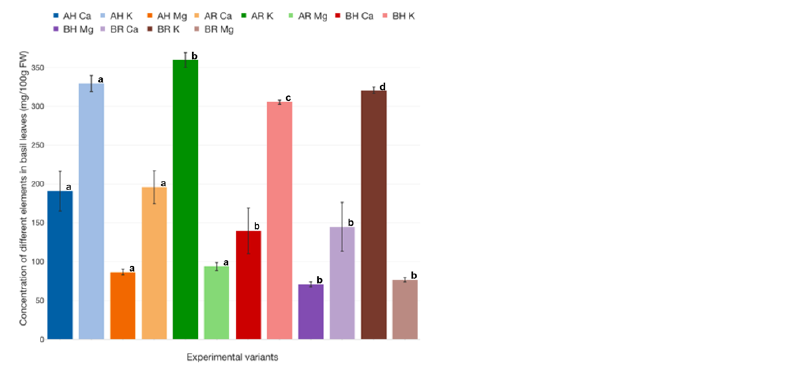
Figure 32. The concentration of different elements (Ca, Mg, K) in basil leaves biomass and SE, growth in each of the experimental variants (Tukey test)—different letters reveal significant statistical differences ( p < 0.05), whereas the same letter reveal not significant statistical differences ( p > 0.05). However, in the case of K concentration in basil leaves, statistically significant dif- ferences ( p < 0.05) are also reported between AR (359.67 ± 7.58 mg/100 g FW) and AH (329.11 ± 8.27 mg/100 gFW). Also, the highest concentration of Mg confirms the previous pattern, being encountered in AR experimental variant (93.57 ± 4.28 mg/100 g FW), while